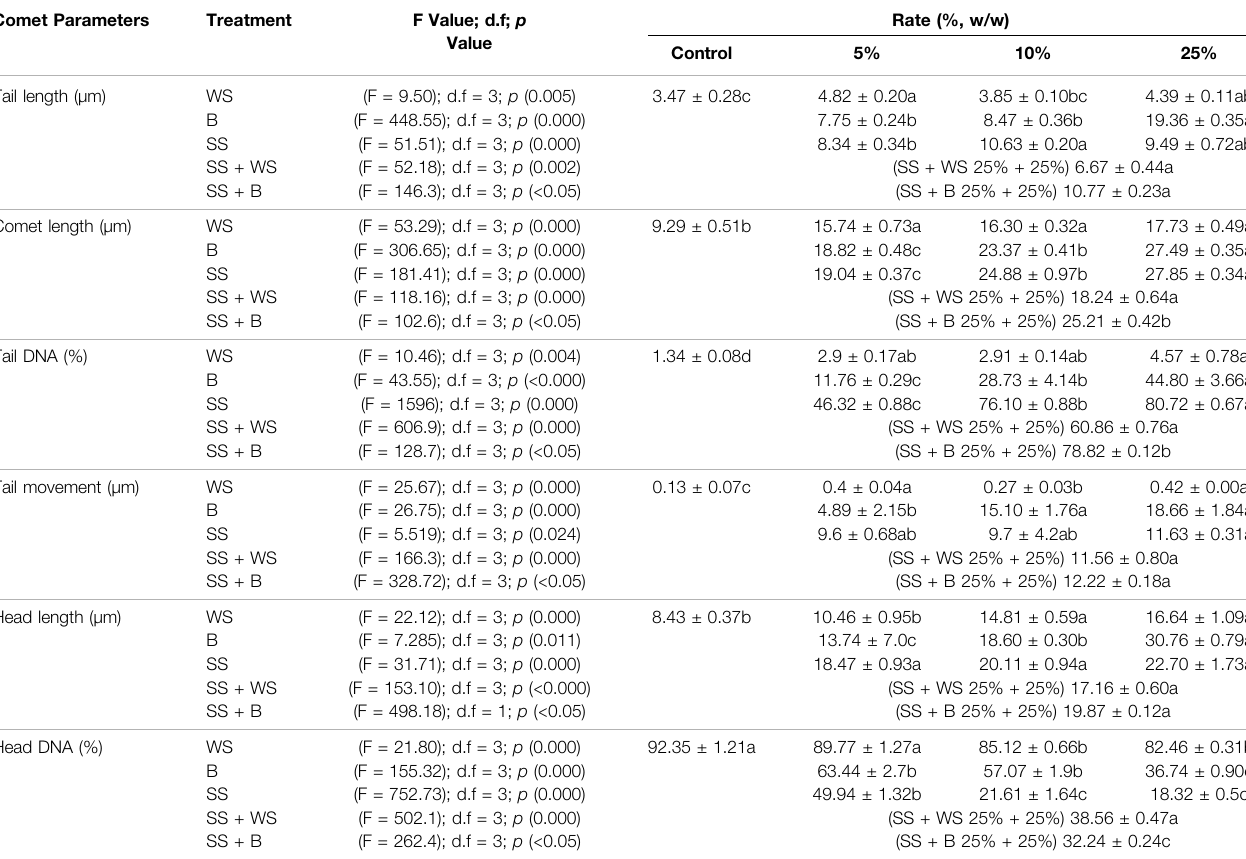
TABLE 3 | Comet parameters after exposure to different concentrations of soil amendments in Pheretima posthuma . Comet Parameters